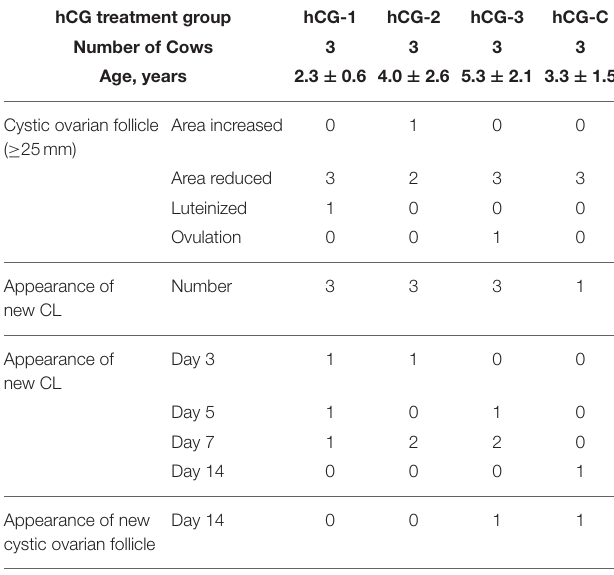
TABLE 1 | Summary of the ovarian activities of four groups during the experimental periods. hCG treatment